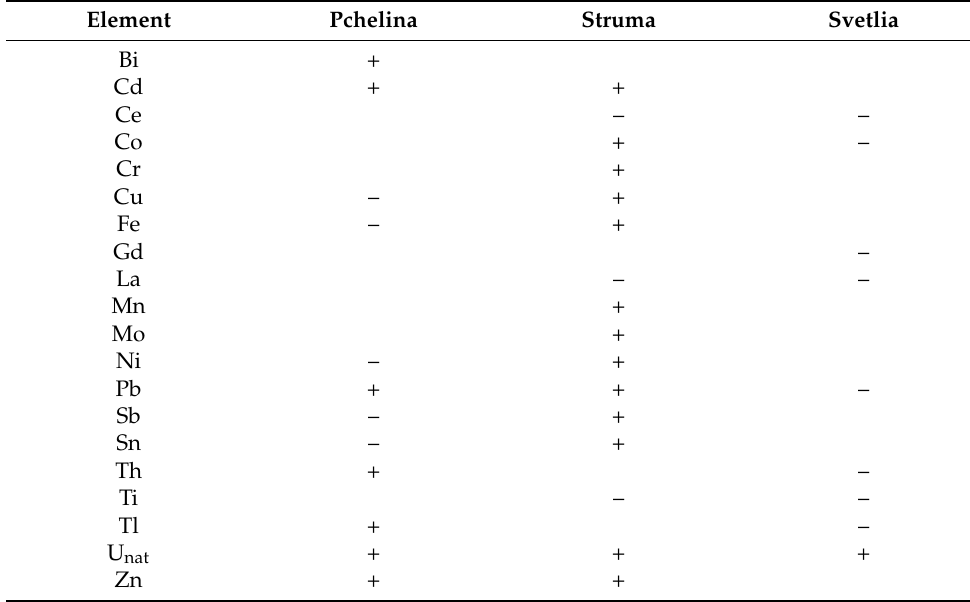
Table 1. Trend analysis of sediment cores at three sampling points.